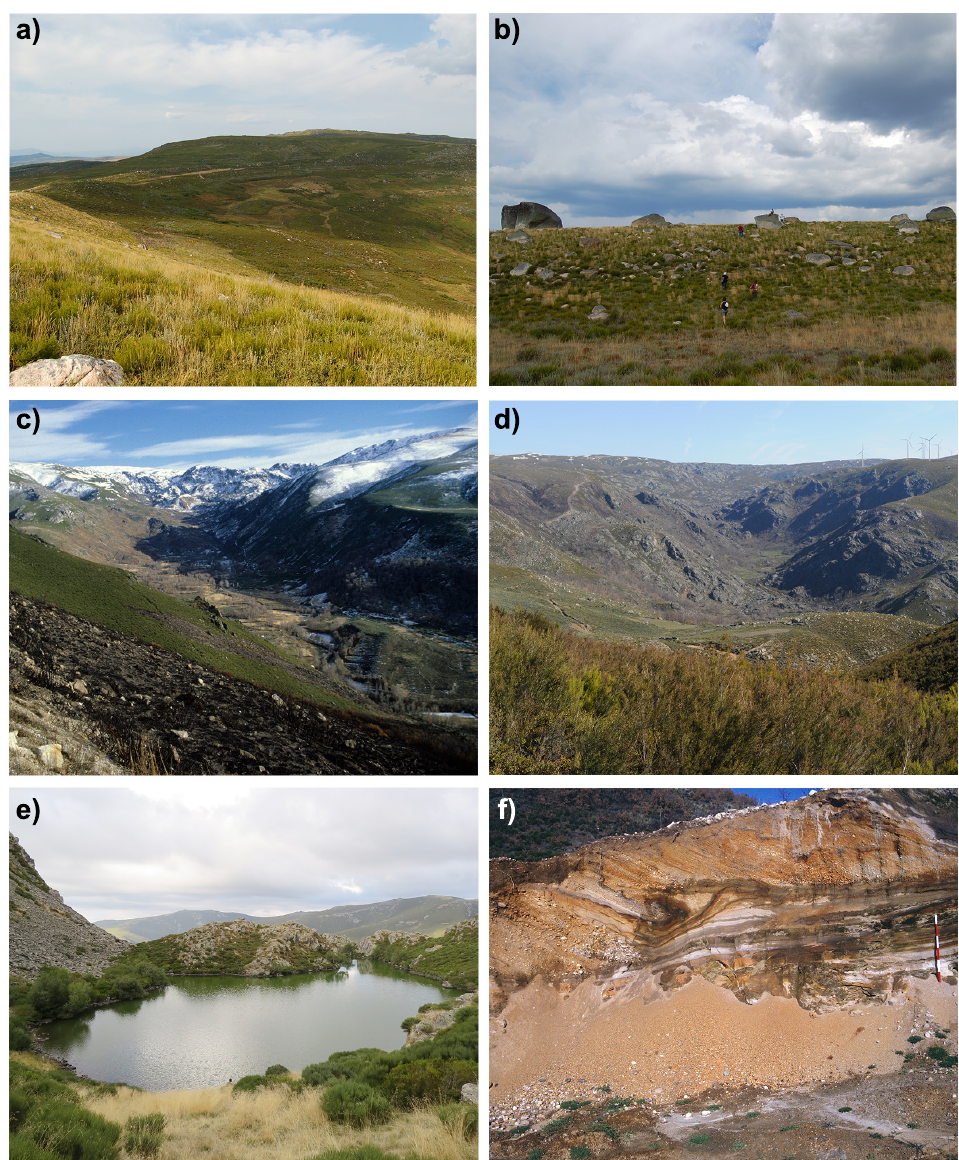
Figure 2. Examples of glacial forms in Trevinca. ( a ) Moraine arches of Cepedelo; ( b ) detail of the upper moraine ridge of image ( a ); ( c ) glacial valley of A Ponte; ( d ) head of the Chanos sector; ( e ) A Serpe glacial lake; and ( f ) glacial deposits in Pías [43]. Photographs by Augusto Pérez-Alberti and Alejandro